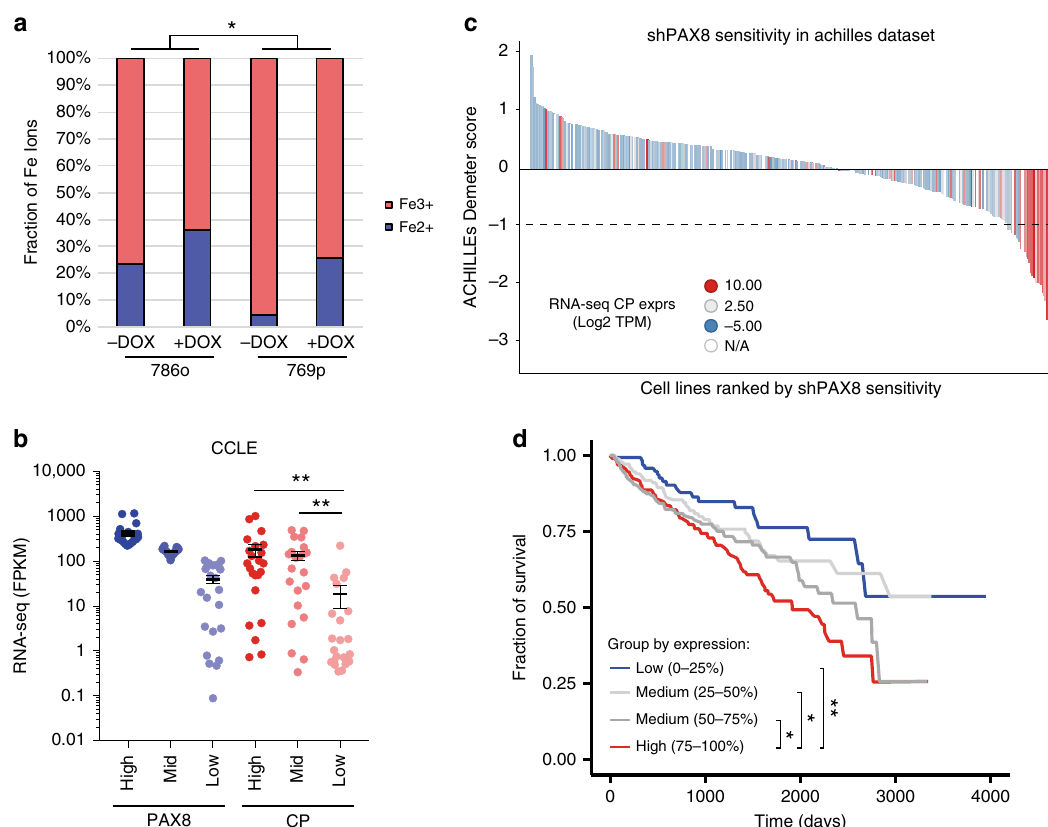
Fig. 4 CP expression tracks with PAX8 sensitivity and RCC cases with poorer survival. a Iron assay kit measurements of different iron oxydation states in 786o and 769p cells conditioned media upon PAX8 knockdown. * p < 0.05 based on ANOVA test. b RNA-seq expression of PAX8 and CP across the cancer cell line encyclopedia segregated evenly according to PAX8 High, Mid, and Low expression. ** p < 0.005 based on Welch ’ s T-test. c Waterfall plot representing the sensitivity (Demeter score) of cell lines to PAX8 knockdown as reported in the Achille ’ s project dataset. Each histogram bar is a cell line and bars are color coded based on the CP expression level (by RNA-seq). d Kaplan – Meyer plot representing the survival of TCGA RCC cases segregated based on CP expression (4 equal-sized bins). * p < 0.05 and ** p < 0.01 according to Mantel – Cox log-rank